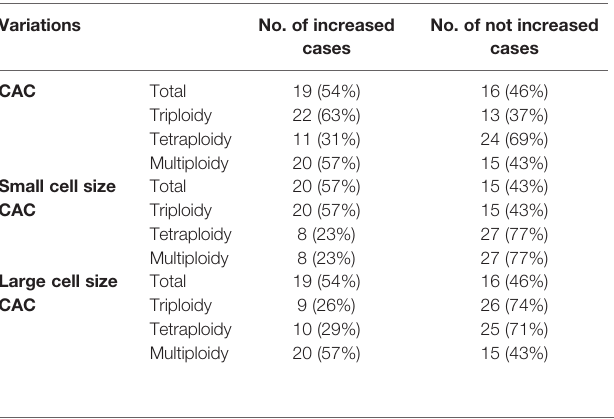
TABLE 7 | CAC variation in the 35 NSCLC cases before and after surgery.